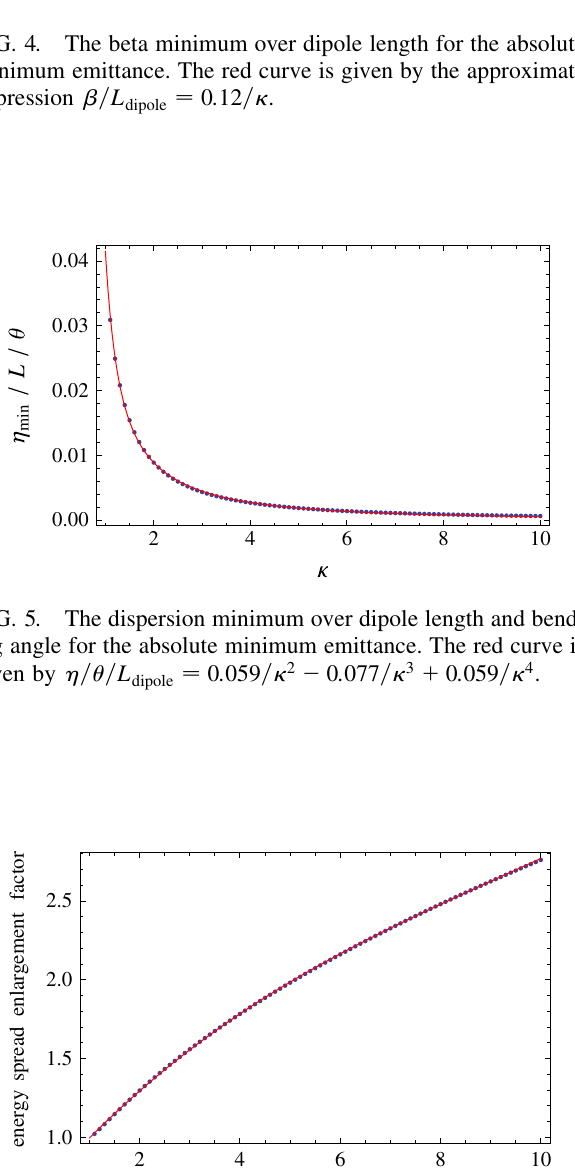
FIG. 6. Beam energy-spread enlargement factor ( (cid:9) of the reference uniform dipole) for the absolute minimum emittance lattice. The red curve is given by the approximate expression 0 : 655 þ 0 : 365 (cid:12) (cid:1) 0 : 0242 (cid:12) 2 þ 0 : 000 885 (cid:12) 3 .